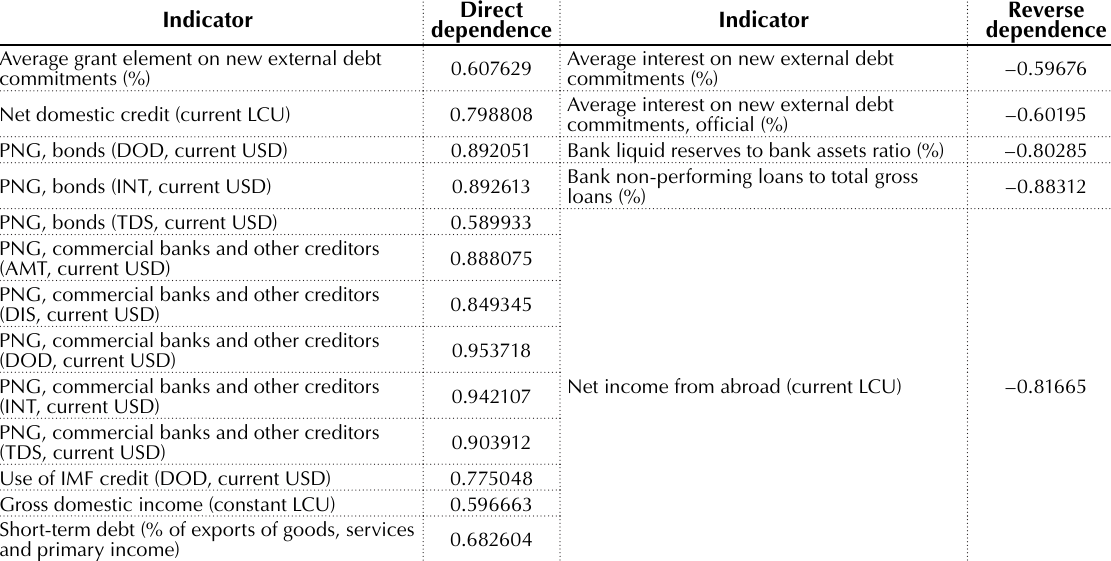
Table 4. Correlation coefficients of the domestic loans to the private sector (% of GDP) with the researched indicators